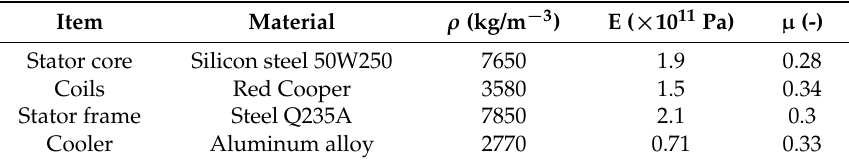
Table 3. Material characteristics.